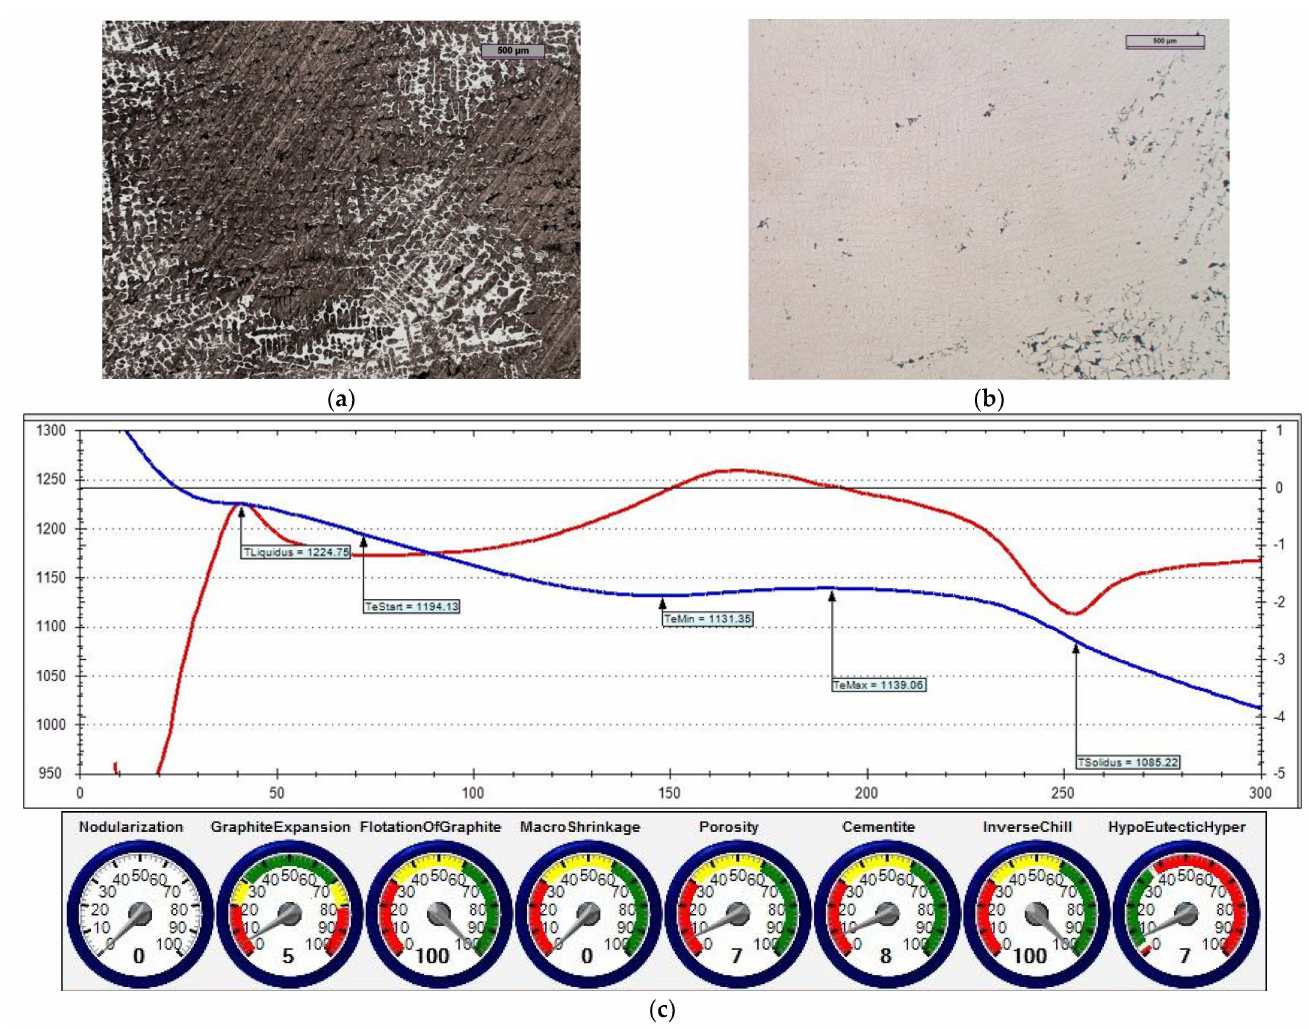
Figure 14. Reference grey cast iron (with 0.014% S content): ( a ) sample etched with Picral reagent; ( b ) non-etched sample; ( c ) changes in cast iron temperature (in time, sec.) during crystallisation and cooling of casting according to ITACA